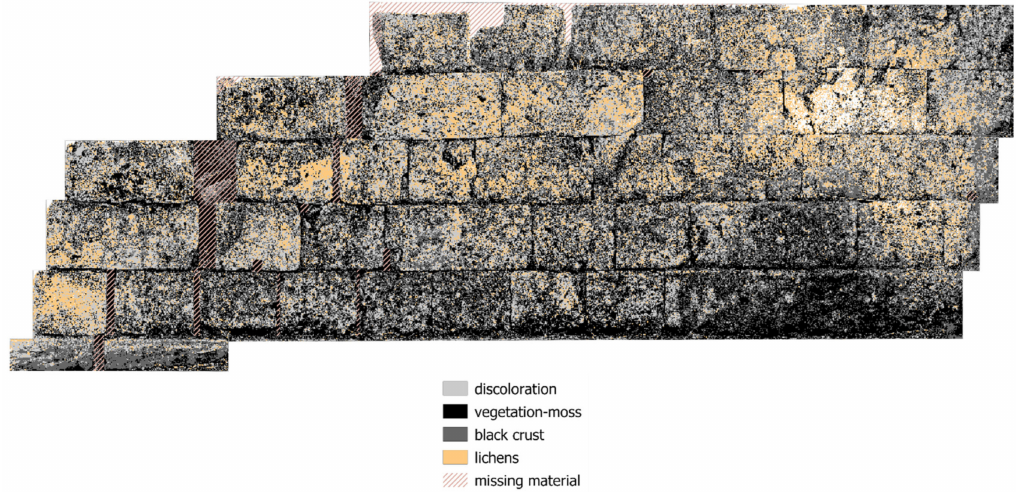
Figure 20. Degradation map of an ancient wall at the archaeological site of Lepreum.